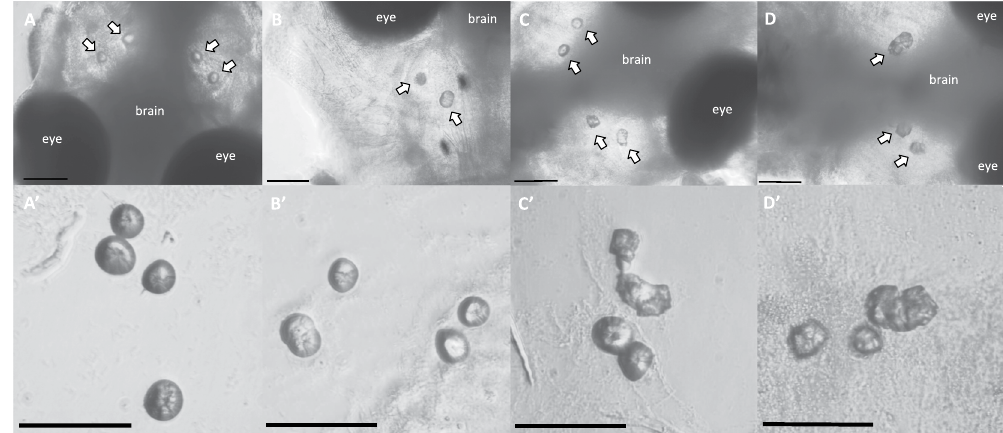
Figure 2. Gilthead sea bream larval otolith morphology. General ( A – D ) and detailed ( A’-D’ ) views of round ( A,B ) and irregular ( C , D ) otoliths in gilthead sea bream larvae exposed to pH7.3. Otoliths inside the larval heads are indicated with white arrows. Scale bars indicate 100 µ